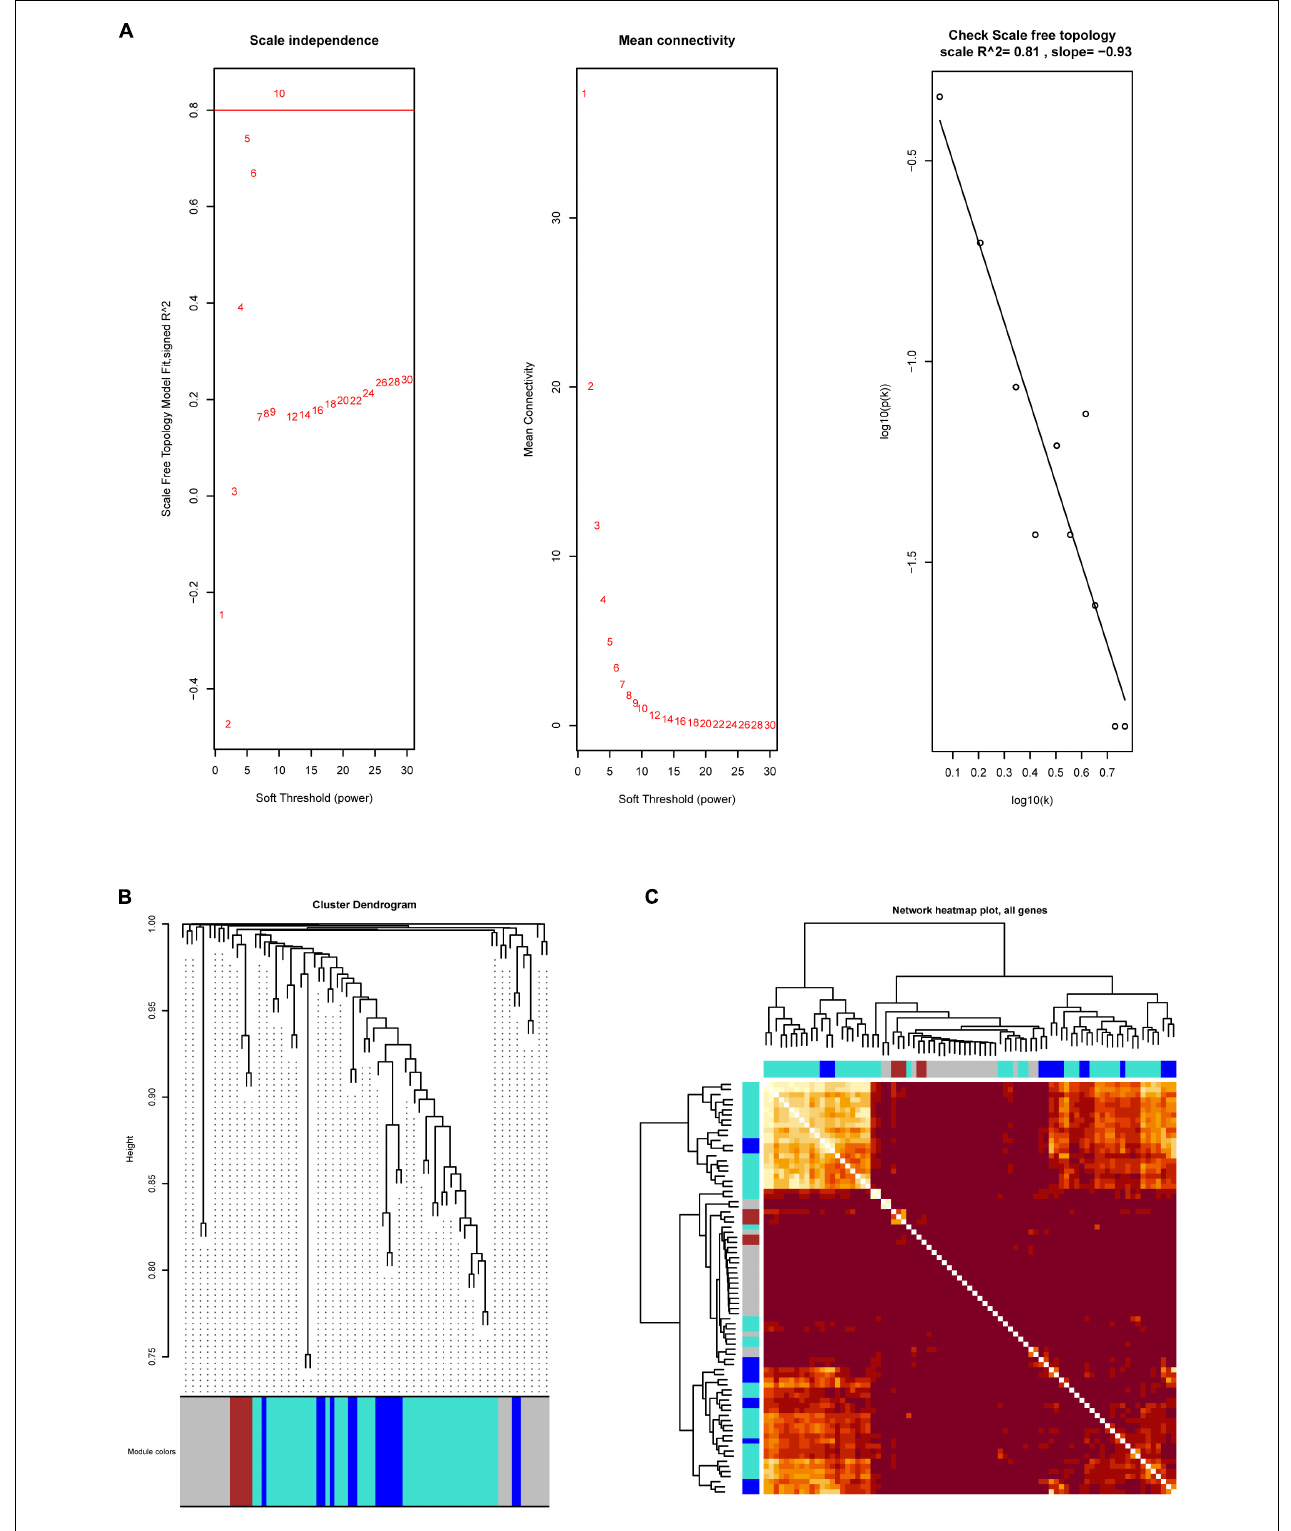
FIGURE 2 | The WGCNA analysis of immune-related DEGs. (A) Network topology analysis to select suitable soft-threshold powers. The x -axis and y -axis reflect the soft-thresholding power and the scale-free topology model fit index, respectively. (B) Clustering dendrogram of genes, with dissimilarity based on topological overlap, together with assigned module colors. (C) Heatmap showing the expression pattern correlation between these modules.